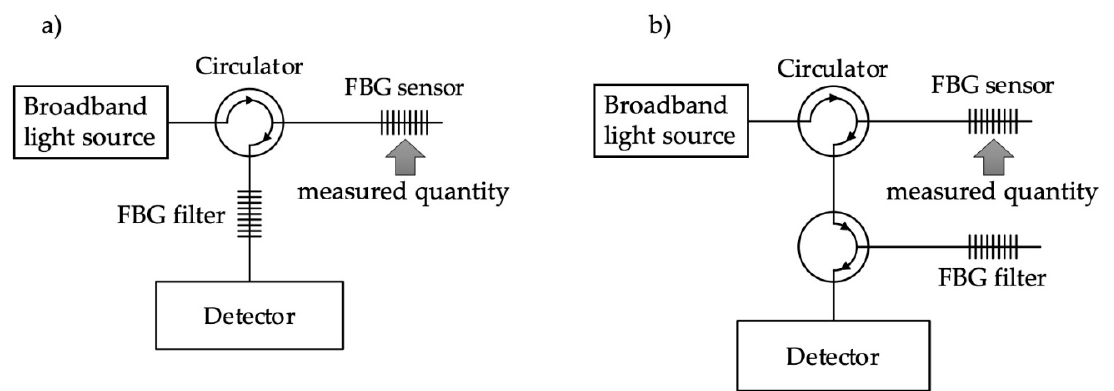
Figure 1. Basic configurations of interrogation systems: ( a ) transmissive; ( b ) reflective.